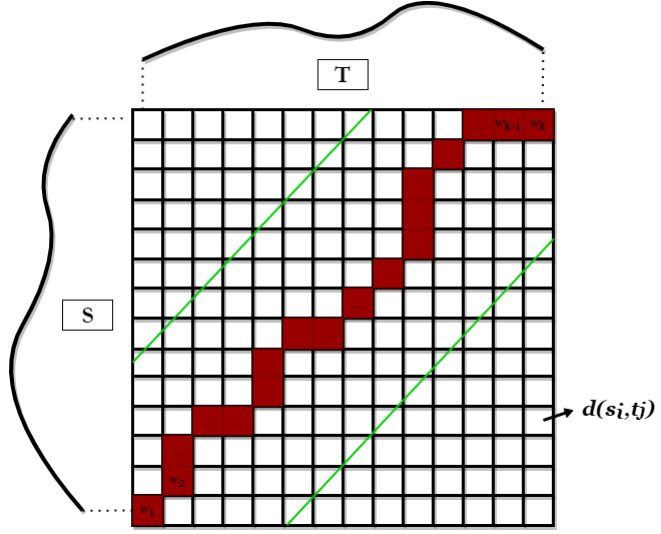
Figure 2. The warping path in